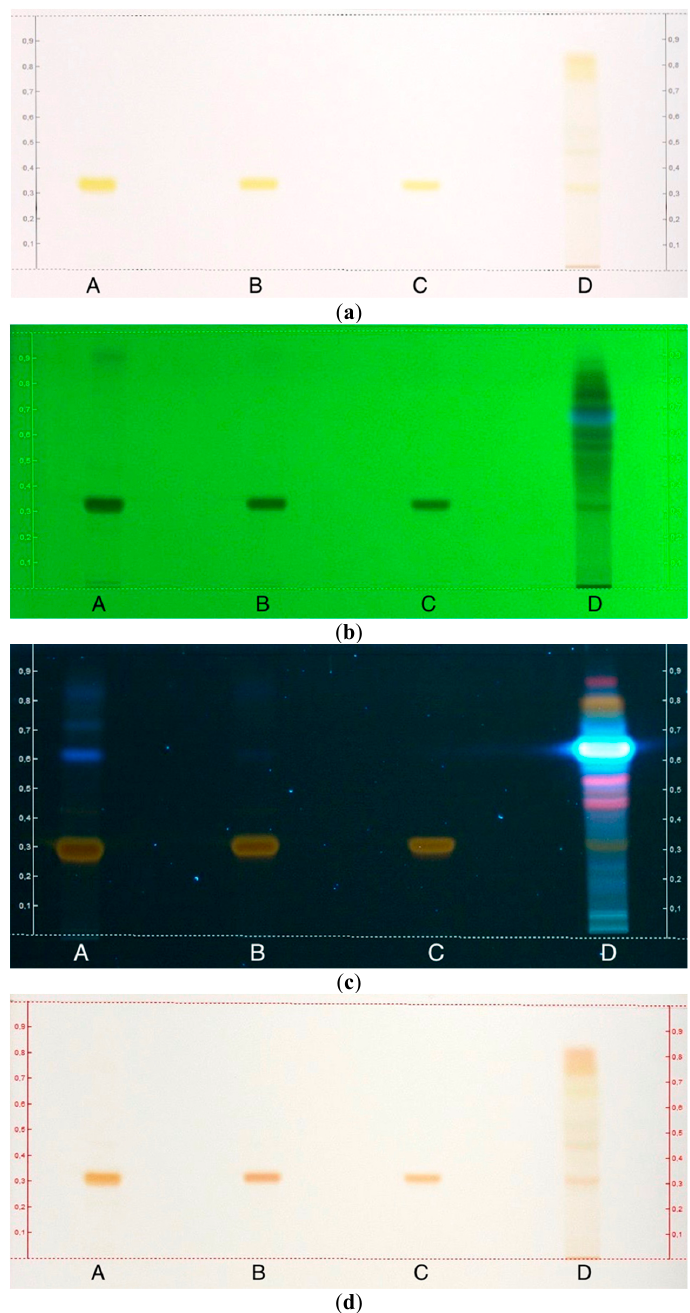
Figure 8. Thin-layer chromatography (TLC) after development at ( a ) visible light, ( b ) 254 nm, ( c ) 366 nm, and ( d ) after spraying with 10% methanolic KOH reagent (A = rhein sample before purification, B = rhein sample after purification, C = rhein standard, and D = residue from the CHCl 3